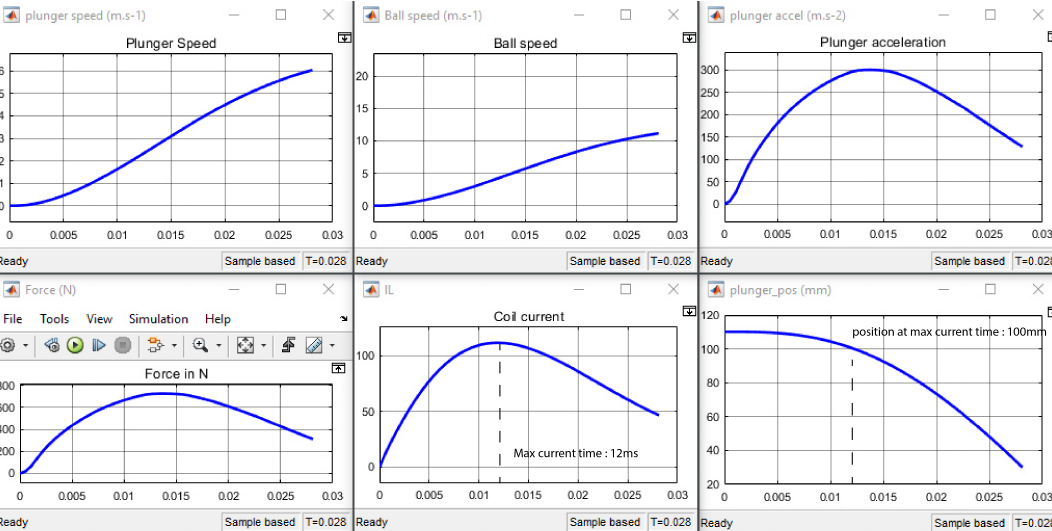
Figure 15. Simulation using the optimal three phase configuration.